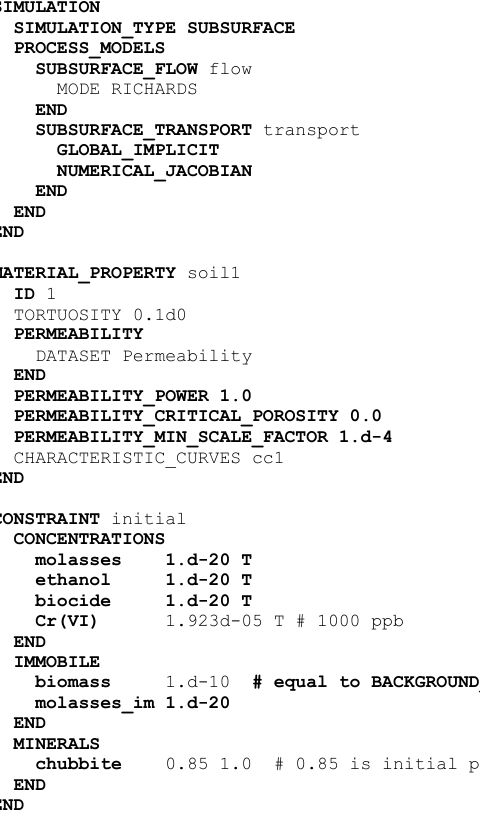
Figure A2. Additional cards that require particular content in order for CHROTRAN to work properly. In the SIMULATION card, the NUMERICAL_JACOBIAN option must be spec- ified. In the MATERIAL_PROPERTY card, the OPTION PERMEABILITY_MIN_SCALE_FACTOR 1.d4 option should be set. In CONSTRAINT cards, species that are not present should have small but non-zero concentrations assigned. The concentration of NAME_B ( biomass , here) should equal BACKGROUND_CONC_B in the CHEMISTRY CARD . Finally, the initial porosity of the system is set by assigning the volume fraction of NAME_BIOMINERAL ( chubbite , here). In general, bold text is required. However, other options may be specified, if desired.